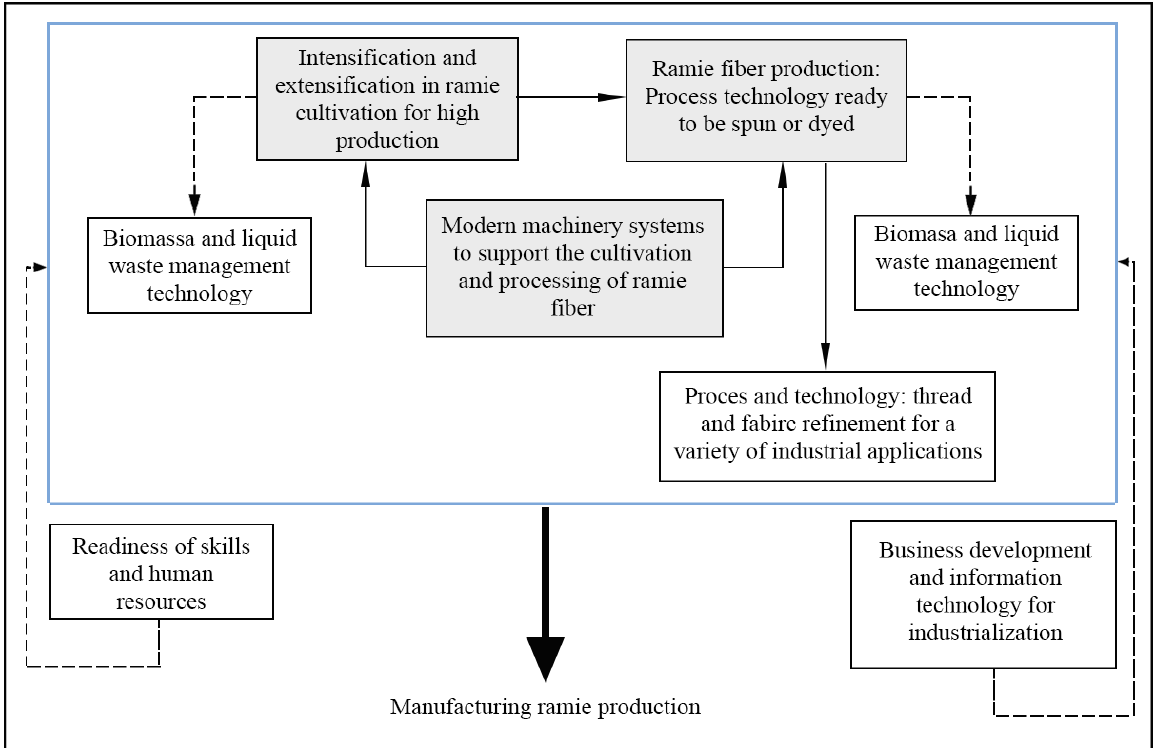
Figure 5. Manufacturing integration strategy in the ramie production system in Indonesia.